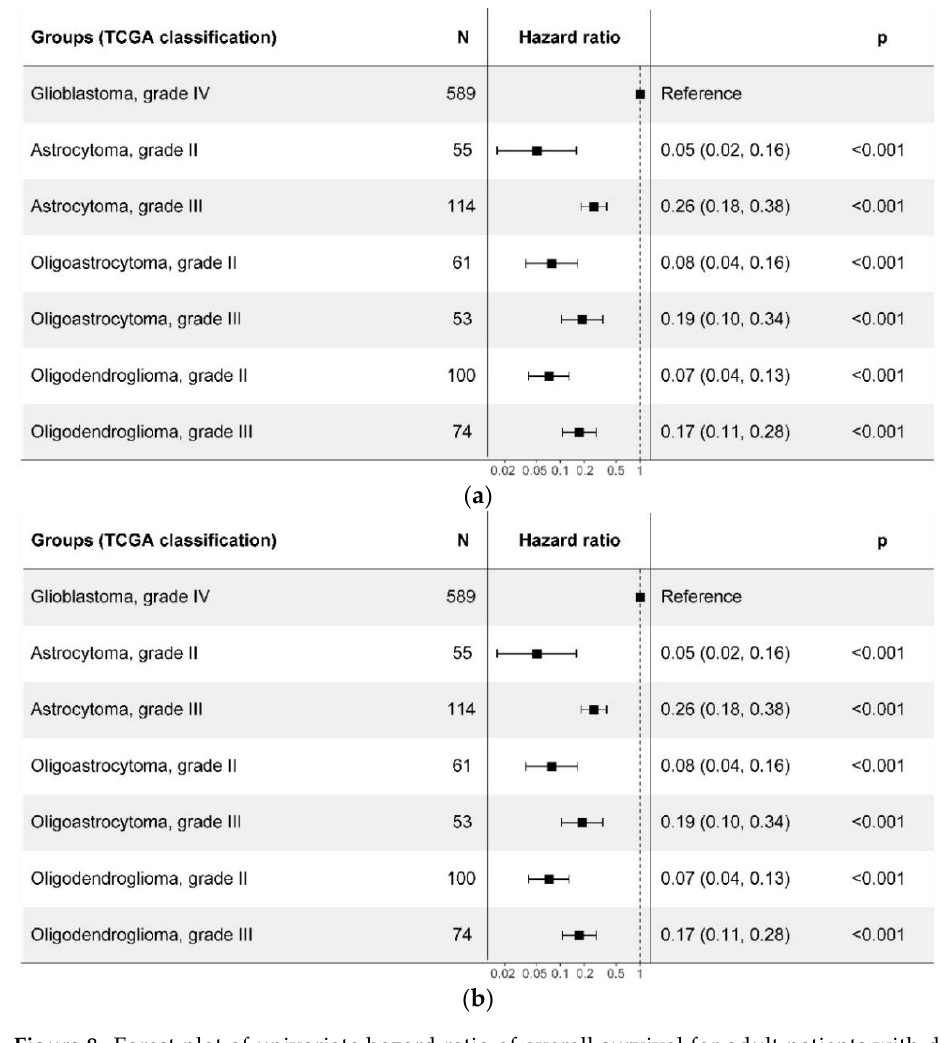
Figure 8. Forest plot of univariate hazard ratio of overall survival for adult patients with diffuse gliomas. Patient groups are shown according to the basic TCGA ( a ) and the WHO CNS5 ( b ) classifications.